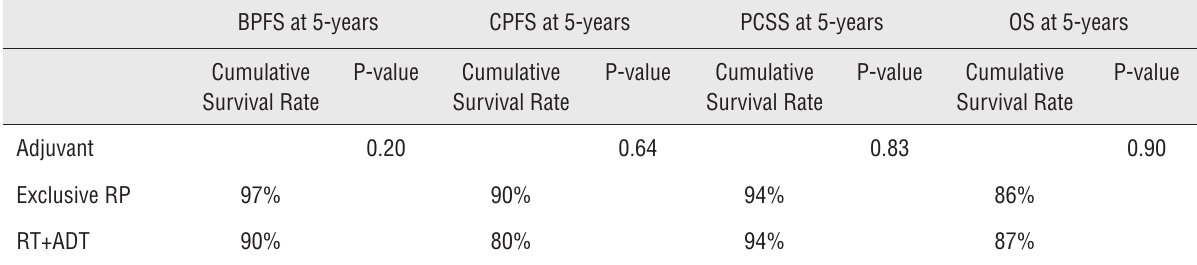
Table 3 - Life tables comparison of BPFS, CPFS, PCSS and OS between both groups.